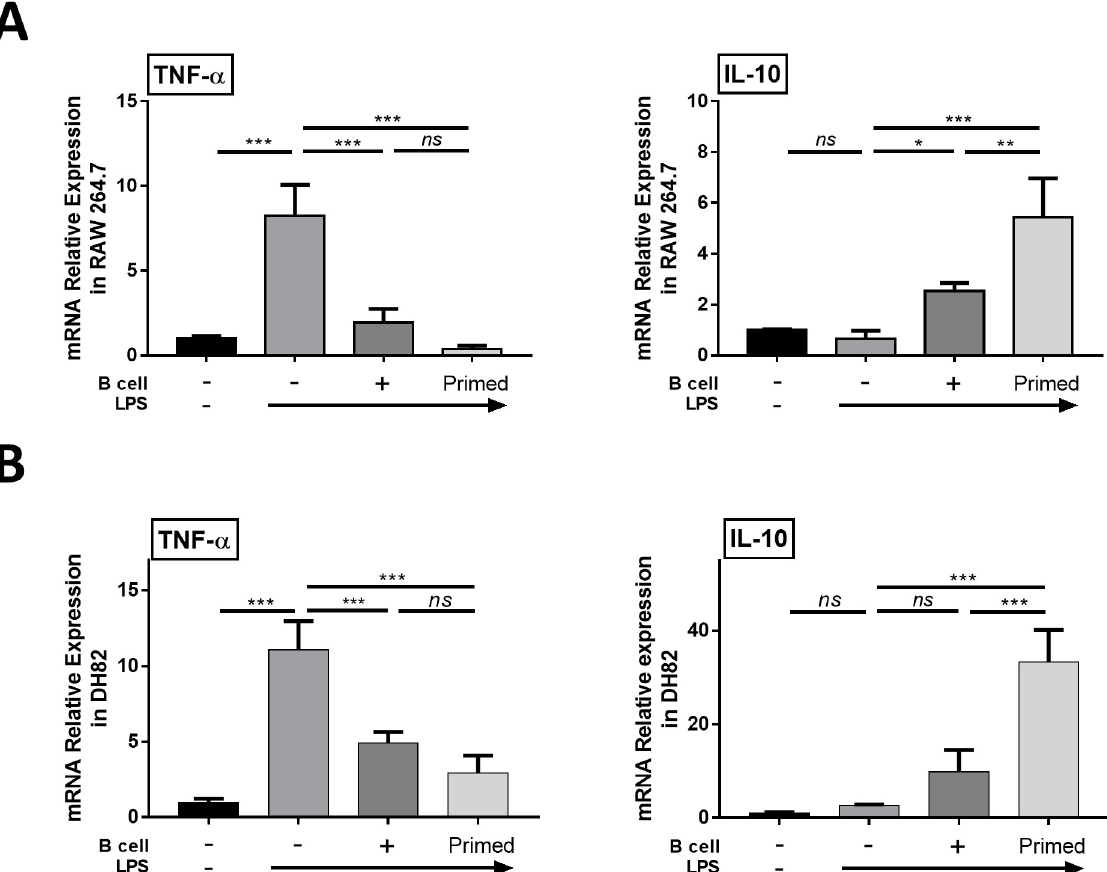
Fig 3. Changed in mRNA expression of inflammation. LPS stimulated RAW 264.7 and DH82 cells were co-cultured with primed B cells for 48 h. (A) Relative mRNA expression levels of TNF- α and IL-10 in RAW 264.7. (B) Relative mRNA expression level of TNF- α and IL-10 in DH82. Data are shown as mean ± standard deviation of three independent experiments ( ns = Not Statistically Significant, � P < 0.05, �� P < 0.01, ��� P < 0.001 by one-way ANOVA analysis).